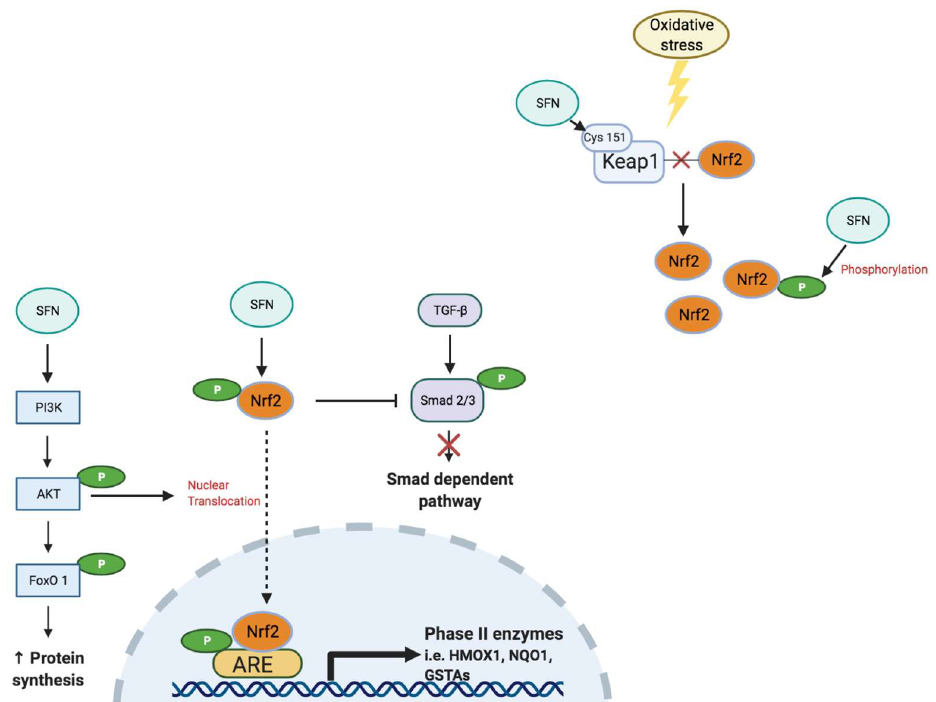
Figure 2. Sulforaphane (SFN) activates the Nrf2 signaling pathway. Under normal conditions, Nrf2 localizes to the cytoplasm, where its activity is suppressed by Keap1. When cells experience extensive oxidative stress, Nrf2 is released from the Keap1 complex and translocates into the nucleus, where it promotes antioxidant and detoxifying gene expression via the antioxidant response element (ARE) complex [39]. SFN regulates activation of Nrf2 and increases the rate of nuclear translocation of Nrf2 [41]. SFN activates Nrf2 via direct modification of critical Keap1 cysteines, such as Cys 151 [42]. SFN can also de-methylate the promoter region of Nrf2 and accelerate Nrf2 protein synthesis [36,42]. Phosphorylated Nrf2 also inhibits phosphorylation of Smad2/3 in the transforming growth factor- β (TGF- β ) signaling pathway linked to an attenuation of tissue fibrosis progression [43]. In addition, SFN can increase protein synthesis and decrease protein degradation via activation of the protein kinase B (Akt)/Forkhead box O1 (FoxO1) signaling pathway [40]. Figure created using